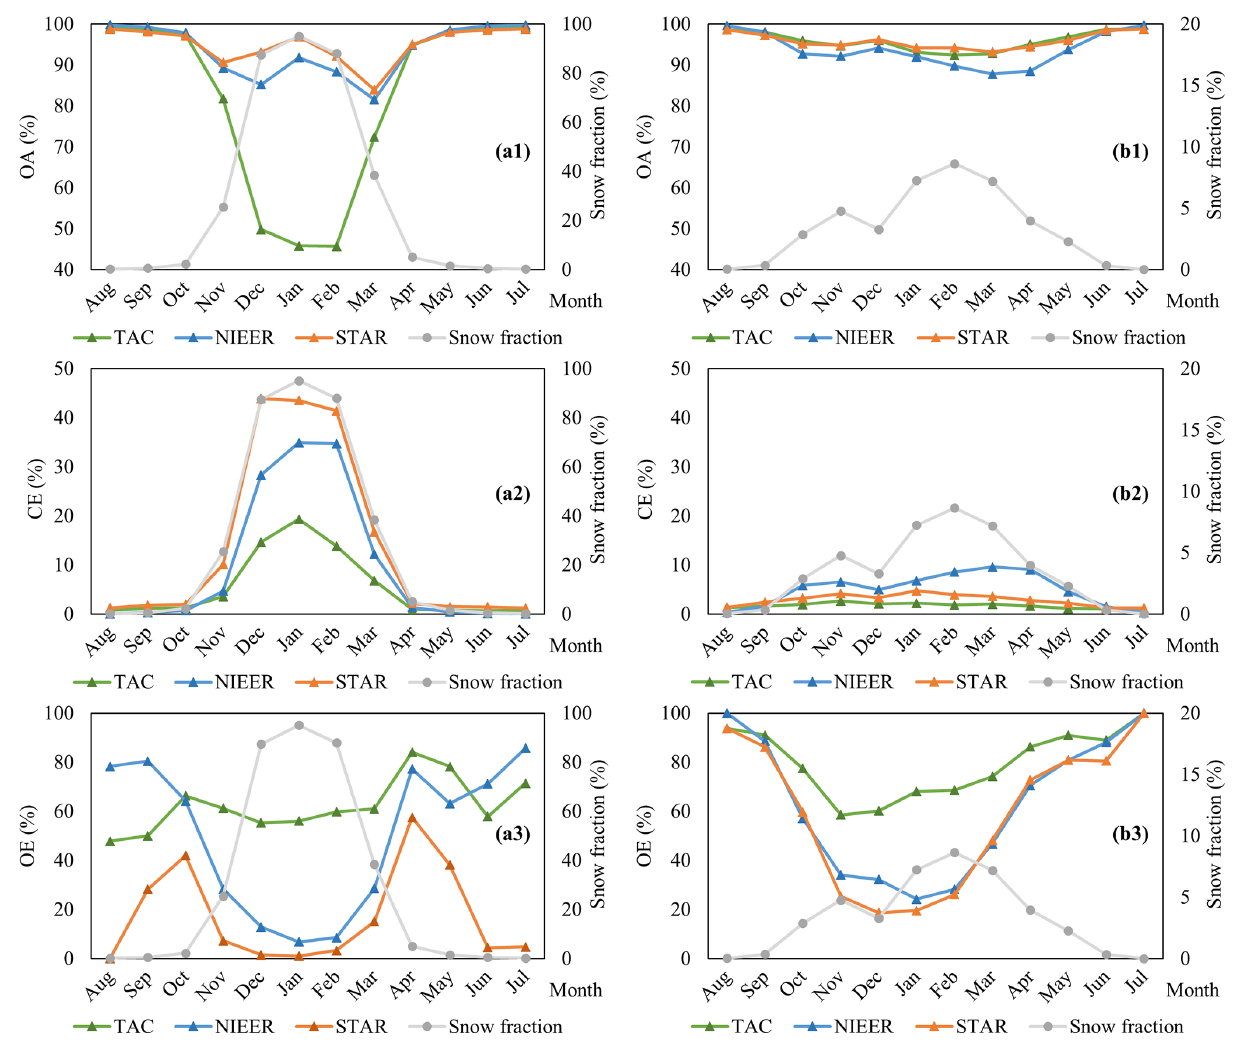
Figure 4. Monthly classification accuracy of TAC NDSI, NIEER AVHRR SCE, and STAR NDSI products in NX (group a) and QTP (group b). Note that the optimal values for OA, CE and OE are 100%, 0% and 0%,